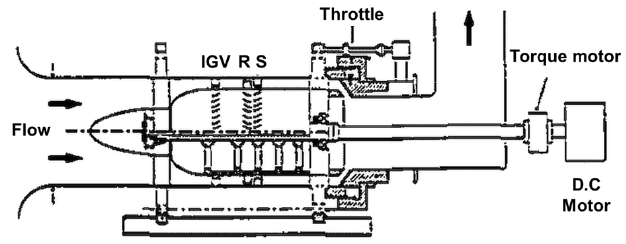
Figure 4. Compressor test equipment [33].